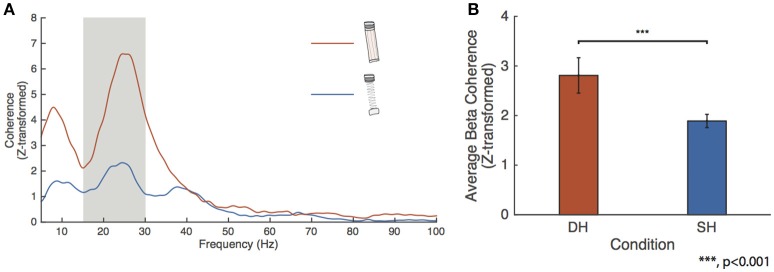
FDI-APB intermuscular coherence. (A) Grand average EMG-EMG coherence calculated between the FDI and APB for the spring-high (SH, blue trace) and dowel-high (DH, orange trace) tasks. Peak coherence was 6.59 at 24.63 Hz for the dowel-high condition and 2.33 at 24.44 Hz for the spring-high task. (B) Linear mixed-effect model results for the effect of condition on FDI-APB coherence. The effect of dowel-high on beta coherence was significantly higher than for the spring-high condition (p < 0.001).